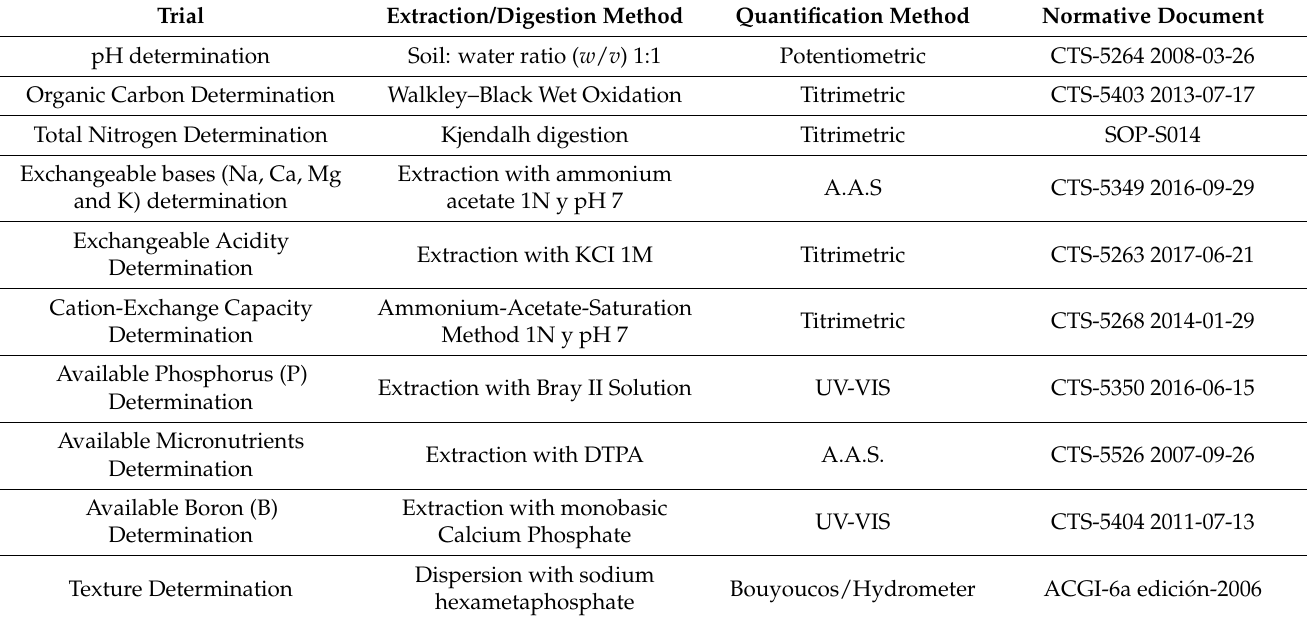
Table 1. Methods of analysis for the determination of physical and chemical variables in physio- graphic position of the Araucanian flooded savannah (Arauca, Colombia, 2021). Extraction/Digestion Method Quantification Method Normative